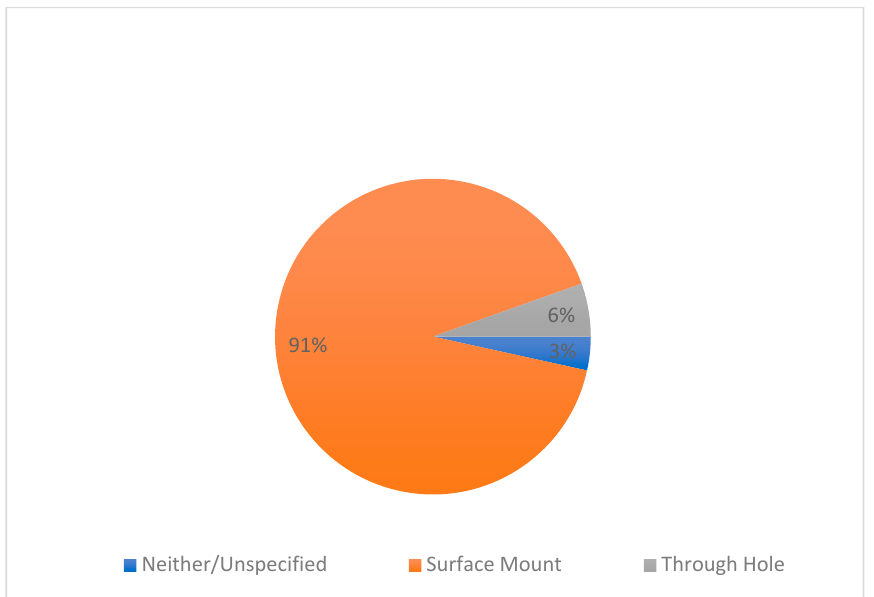
Figure 4. Number of surface-mount versus through-hole component product o ff erings.